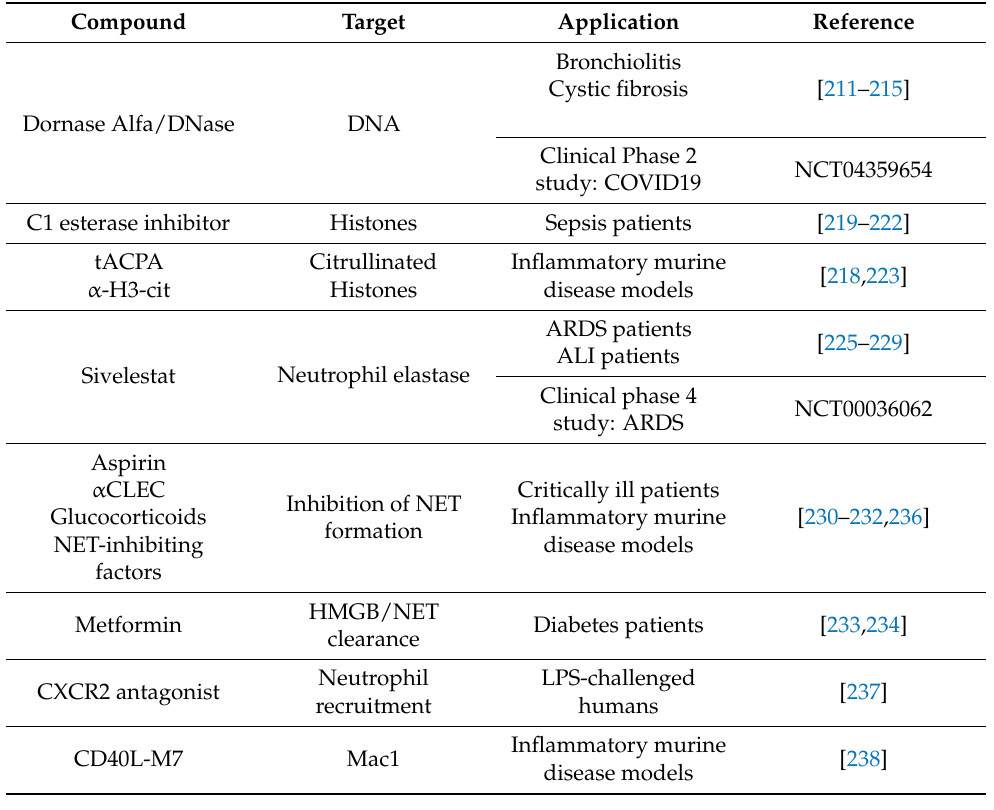
Table 1. Summary of NET-targeting therapeutics or compounds in preclinical and clinical